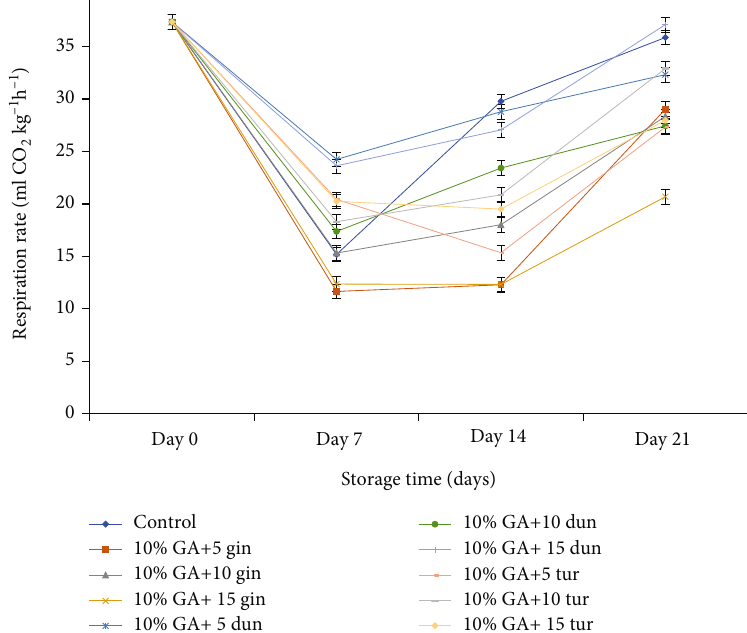
Figure 11: E ff ect of 10% GA incorporated with plant extracts at di ff erent concentrations on respiration rate during cold storage for 21